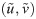
Patient pathology dynamics in primary tauopathy.(Left) Phase plane (u˜,v˜) with four equilibria. Homogeneous dynamics of the toxic states. Note that this is a two-dimensional slice of the four-dimensional phase space. (Right) When four different states co-exist, only the fully toxic state is stable as shown by the time-dynamics plot. (Parameters: a0 = b0 = a1 = a2 = b1 = b2 = 1, a˜1=b˜1=3/4, b3 = 1/2).